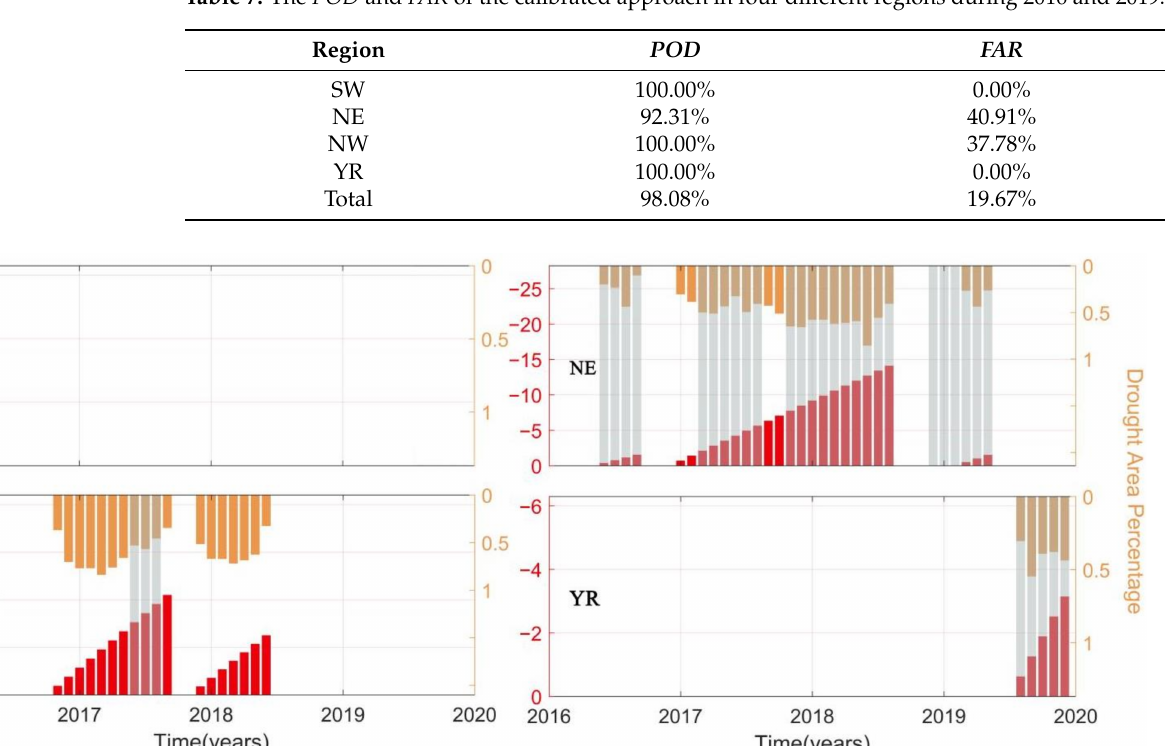
Table 7. The POD and FAR of the calibrated approach in four different regions during 2016 and 2019.